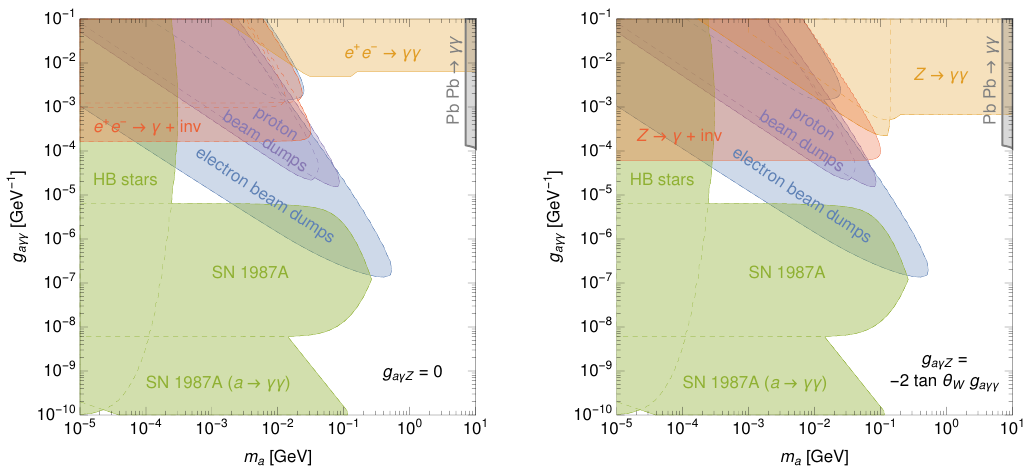
Figure 2 . Existing constraints on ALPs with photon coupling (left) and hypercharge coupling (right). Proton beam dump constraints are taken from ref. [22], LEP constraints on e + e (cid:0) ! (cid:13)(cid:13) from ref. [21], CDF constraints on Z ! (cid:13)(cid:13) from ref. [28], bounds from horizontal branch stars